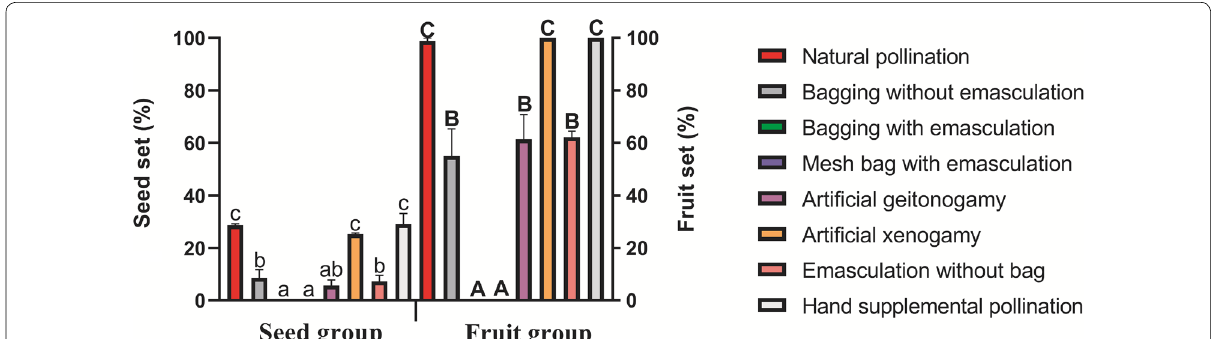
Different lowercase letters in the same column indicate significant differences among pollination treatments ( P < 0.05)